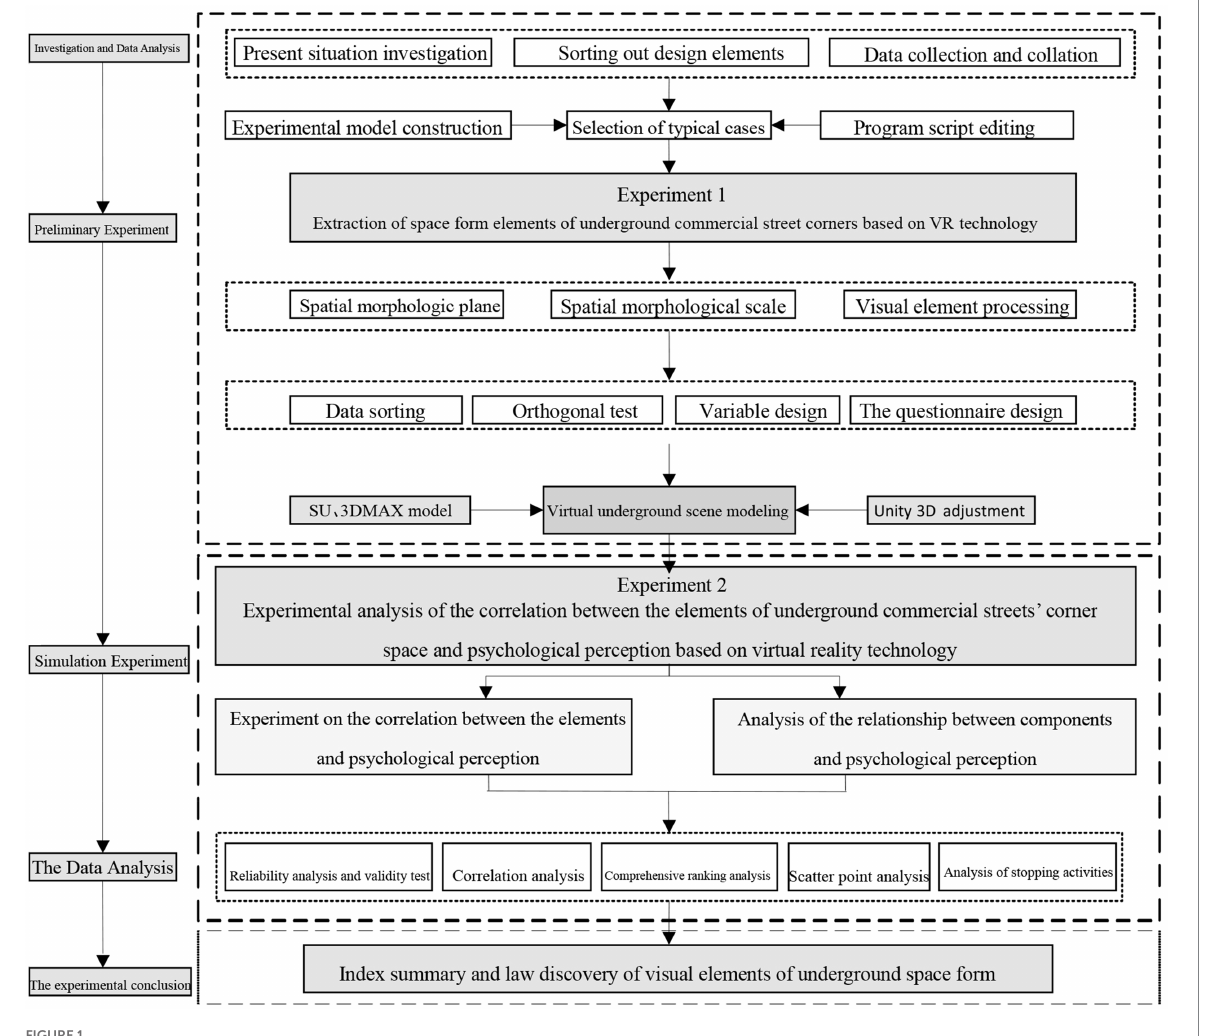
FIGURE 1 The research technology